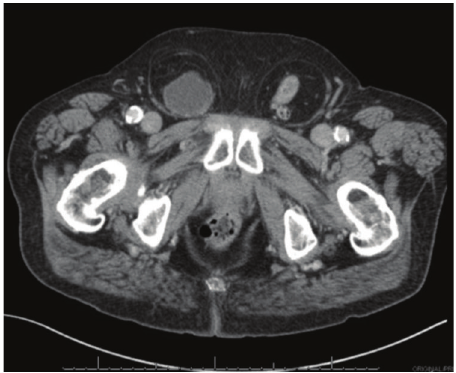
Figure 3: Axial view of bladder hernia in right inguinal canal and colon in left inguinal